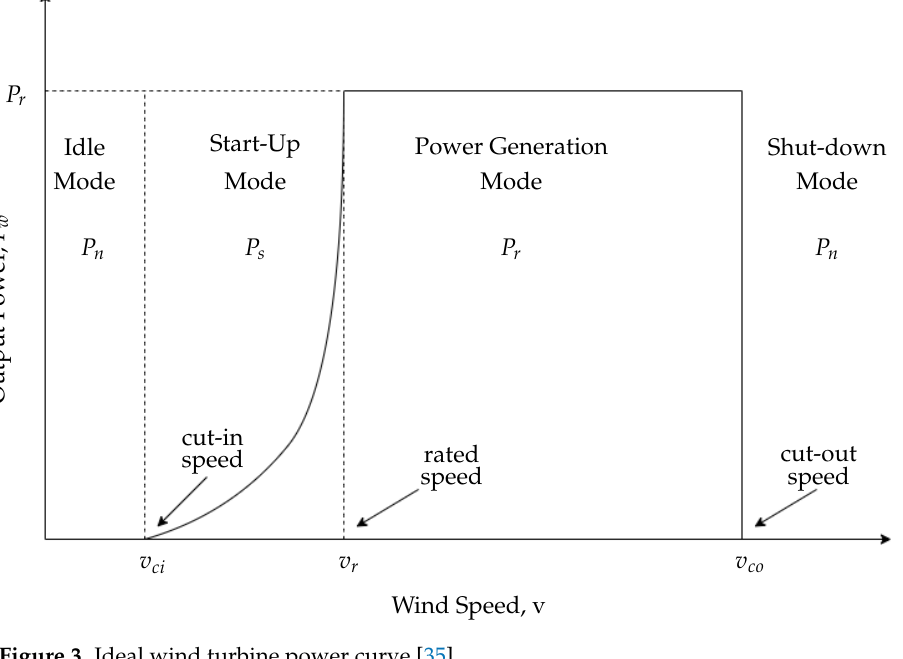
Figure 3. Ideal wind turbine power curve [35].